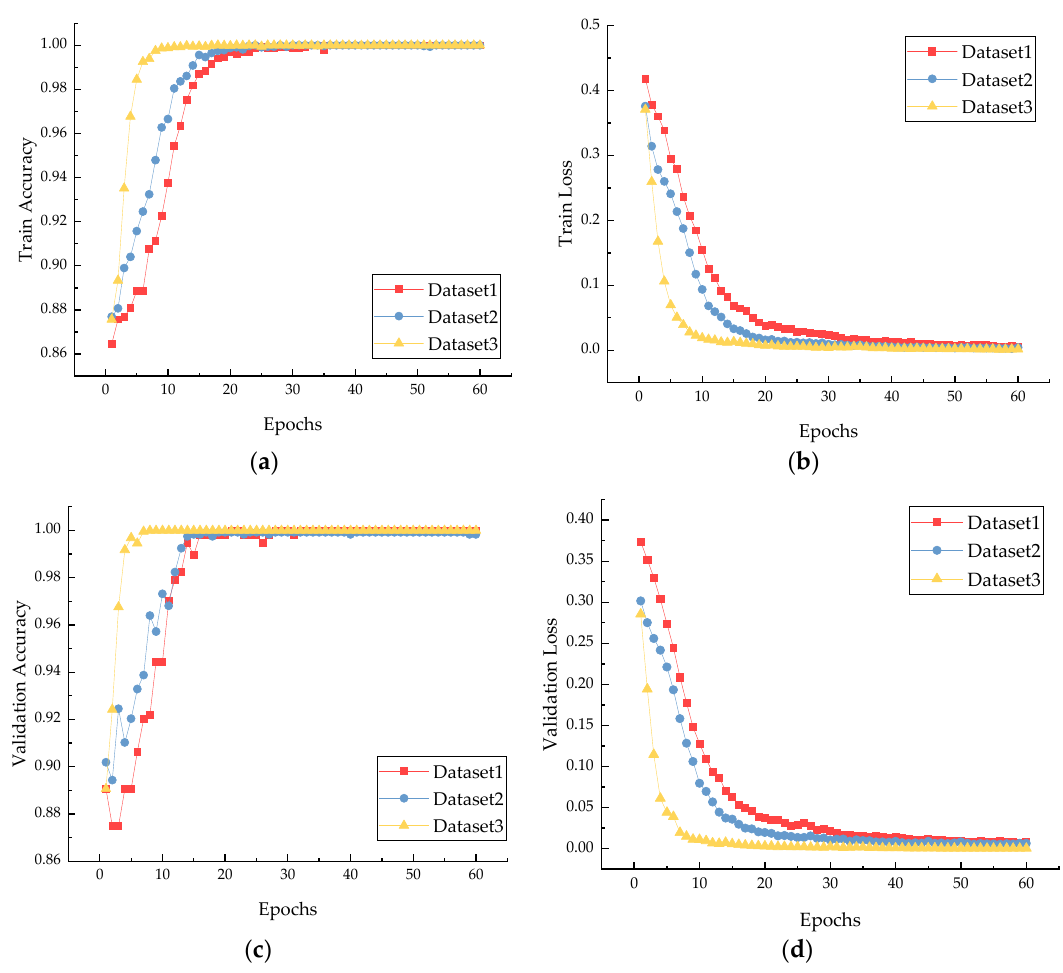
Figure 10. Experimental results for balanced bearing Dataset 1, Dataset 2, and Dataset 3: ( a ) train accuracy; ( b ) train loss; ( c ) validation accuracy; ( d ) validation loss.